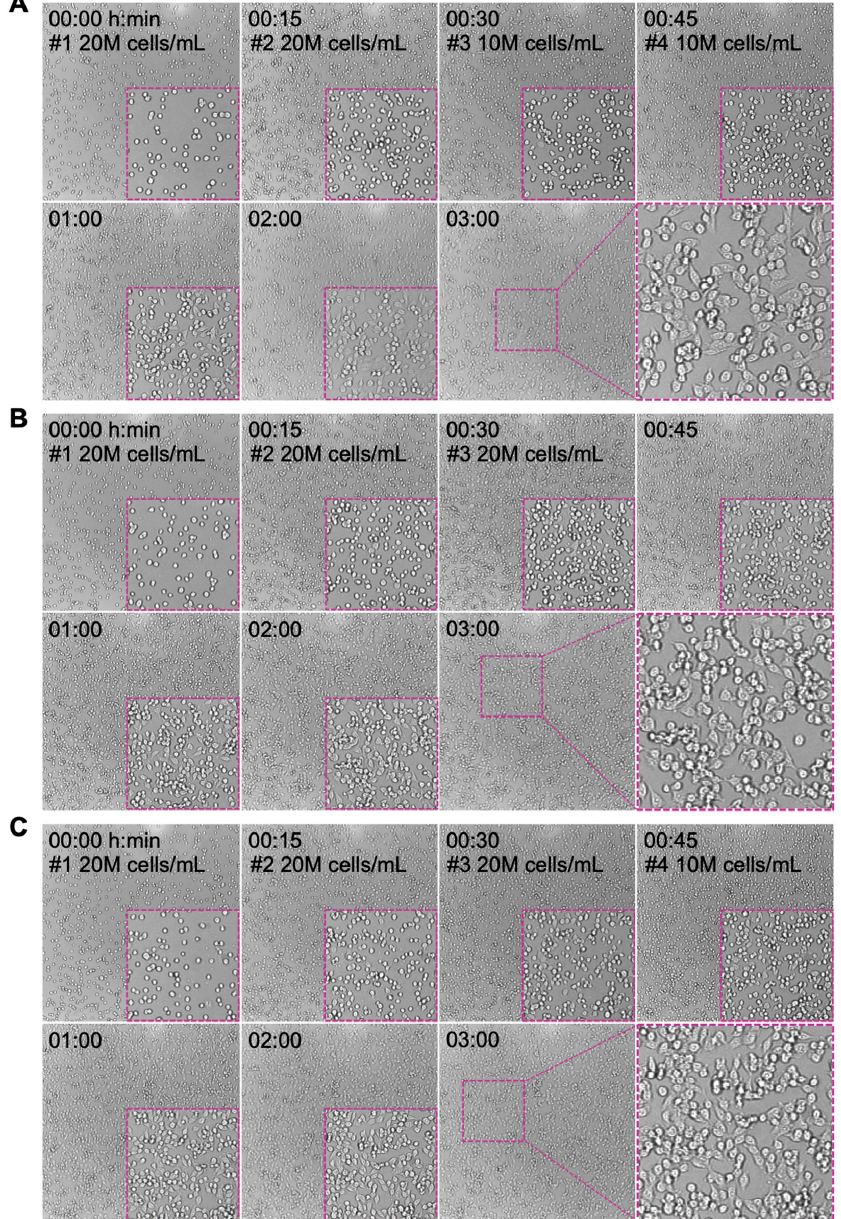
Figure 4. Seeding optimization to achieve target monolayer without clumpy cells. MCF-7 cells are highly clumpy at high seeding concentrations. Multiple rounds of cells seeding with low cell density were performed to avoid cell clumping. Three seeding procedures were conducted: ( A ) 20 × 10 6 cells/mL seeding for two times followed by two times at 10 × 10 6 cells/mL; ( B ) 20 × 10 6 cells/mL seeding for three times; ( C ) 20 × 10 6 cells/mL seeding for three times followed by additional seeding at 10 × 10 6 cells/mL. The interval time was 15 min. The monolayer condition for each seeding procedures at indicated time points was imaged and presented. Insert: the zoom-in images showing the confluency of cell monolayer and the cell morphology.